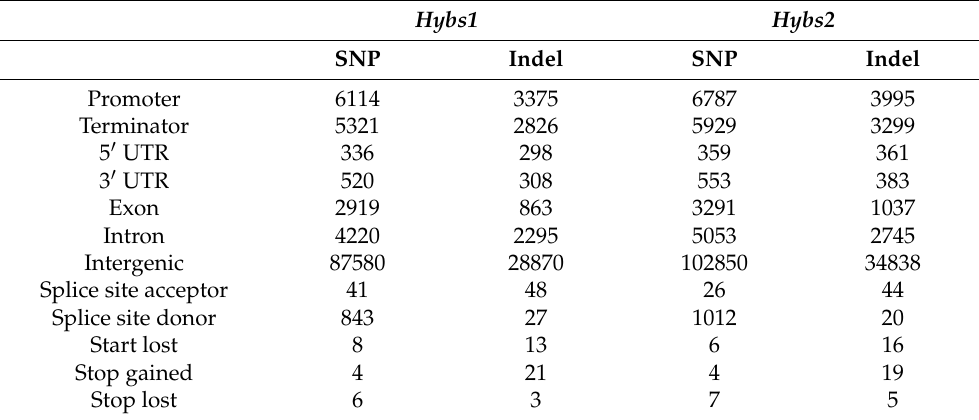
Table 2. The number of SNPs/indels in six genomic elements and the number of large-effect